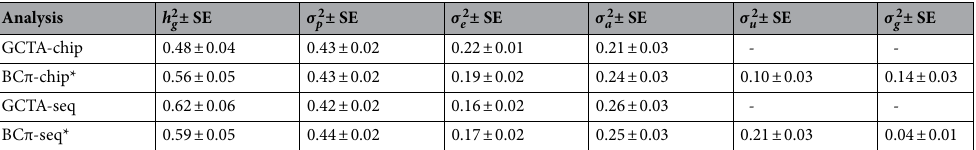
Table 3 pre- sents the variance components and the heritability of the sexual phenotype estimated with the different genomic models using either the 30,811 SNPs of the chip or the 8,784,147 SNPs from the WGS. The estimated heritability of maleness was high, ranging from 0.48 with the GCTA-chip analysis to 0.62 with the GCTA-seq analysis. The estimated genetic variance ( σ 2 a ) was consistent across all models, with the lower value obtained for GCTA-chip (0.21), intermediate values obtained with BayesCπ models (0.24 and 0.25 for BCπ-chip and BCπ-seq, respec- tively) and the highest value (0.26) obtained with the GCTA-seq analysis. The estimate values of genetic variance increased with the number of SNPs (from 31K to WGS) included in the model and with the addition of a poly- genic effect under a Bayesian approach, showing that the 31K SNPs genotyped were insufficient to capture all the genetic variation. Therefore, the actual heritability of maleness in rainbow trout is expected to be about 0.6. Based on the BCπ-chip model, we estimated that the genetic variance ( σ 2 g ) explained by the 31K SNPs spanning the whole genome accounted for only 58% of the total genetic variance of sex ( σ 2 a , Table 3). Using the BCπ-seq model allowed to focus the analysis on the most relevant genomic regions and showed that the genetic variance ( σ 2 g ) explained by the sequence segment spanning the 4 Mb located between 62 and 66 Mb on Omy1 accounted for 16% of the total genetic variance of sex ( σ 2 a , Table 3). Genome wide association studies for maleness in XX‑female rainbow trout. GCTA-chip and BCπ-chip approaches at the 31K genotyping level. Based on the 31K SNPs, we detected four QTLs associated with maleness on three different chromosomes (Omy1, 12 and 20) with the GCTA and the BayesCπ analyses (Table 4). With the GCTA-chip analysis, we detected two QTL on Omy1, the first one being suggestive only and explaining less than 0.2% of the total genetic variance. The second QTL was significant at the genome-wide level, under GCTA-chip analysis (− log GCTA peak SNP being located 212 kb before the BCπ peak SNP, they were in close vicinity with only three mark- ers in-between the two peak SNPs. This second QTL explained 3.9% of the total genetic variance. We did not distinguish the two QTL with the BCπ-chip approach, as the credibility interval estimated with BCπ-chip was 1.7 Mb and contained the two peak SNPs detected with GCTA-chip. The two other QTLs located on Omy12 and Omy20 were detected using the BCπ-chip approach only (Table 4). The QTL located on Omy12 explained 0.6% of the total genetic variance. The QTL on Omy20, defined by a single SNP located at 31.352 Mb, explained 0.4% of the total genetic variance. This QTL was suggestive at 5% at the chromosome-wide level under GCTA-chip analysis (-log 10 (P-value) = 4.2).